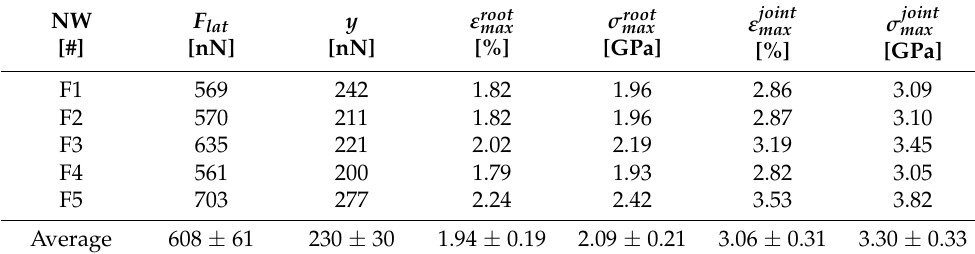
Figure 7. Bending curves of NW F2 taken in the scanning line of the fracture event ( a ). Calculated maximal strain at the surface from bottom to the top of the NW along the z -axis at changing radius ( b ). Comsol simulation of volumetric strain ( c ). The maximal value was located near to the interface of TC–THP segments. Table 2. Results of the fracture tests on 5 NWs (F1–F5): applied load ( F lat ), NW deflection ( y ), calculated maximal strain/stress at the root of the NW ( ε root max / σ root max at z = 0) and at the joint of TC/THP segments ( ε joint max / σ joint max at z = L 1 ). For the calculation average geometrical parameters and E BM were used (last raw in Table